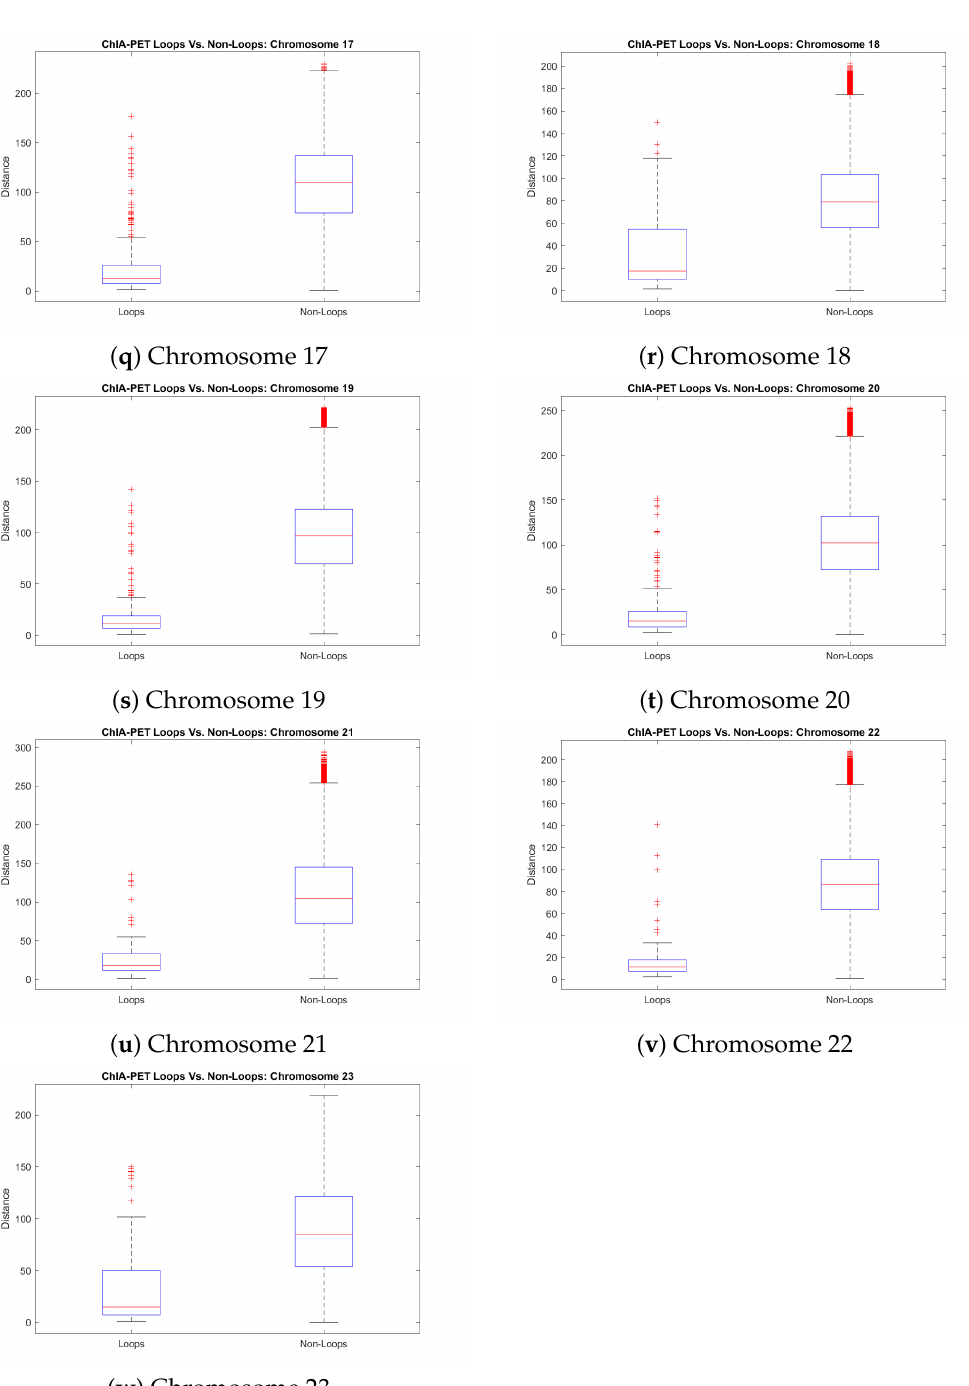
Figure A3. Comparisons of the looped and non-looped distances of CBCR’s outputs at 100kb resolution for the ChIA-PET